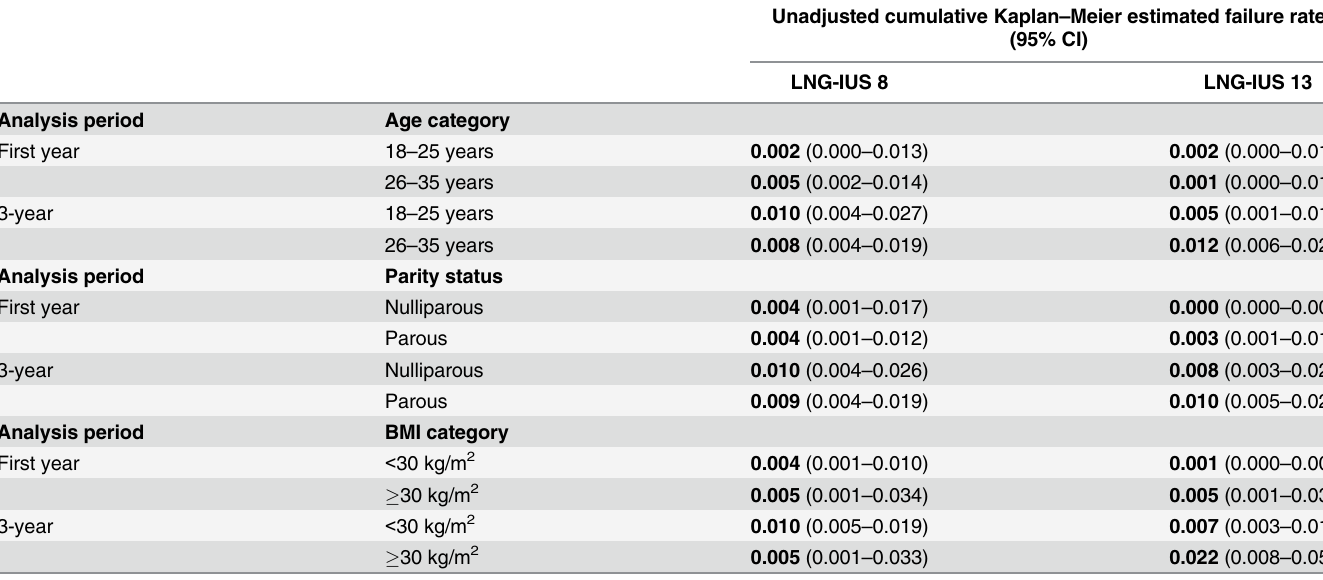
Table 3. First-year and 3-year Unadjusted Cumulative Kaplan – Meier Failure Rates: Subgroup Analyses by BMI, Age and Parity (Full Analysis Set).